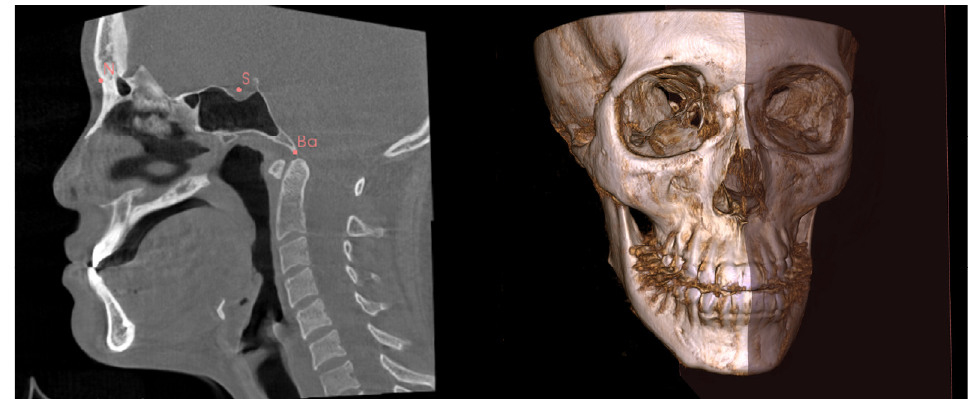
Figure 1. Identification of the N (Nasion), S (Sella), and Ba (Basion) for construction of the mid-sagittal plane (MSP). The MSP bisects the face into left and right halves. Patients with the perpendicular distance from the menton point to the MSP ≤ 2.0 mm or >2.0 mm were assigned to the symmetric and asymmetric groups, respectively. Fifty patients were divided into two groups: the symmetric group ( n = 25) and the asymmetric group ( n = 25). The side of menton deviation was referred to as the deviated side, and the other side was referred to as the non-deviated side.